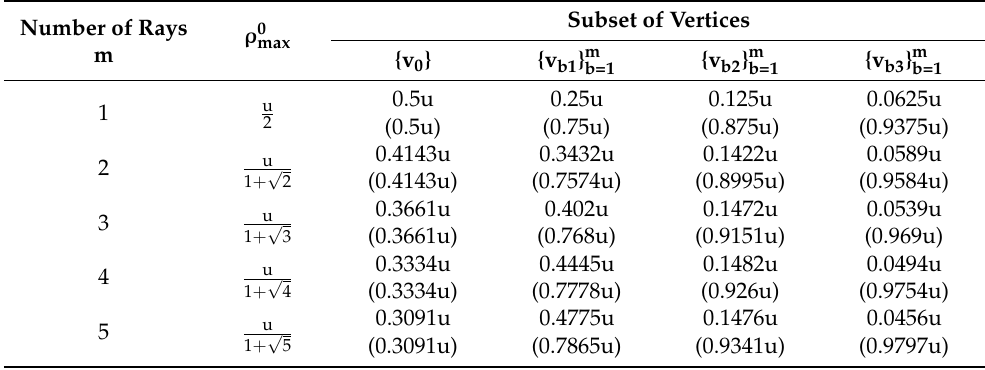
Table 2. Upper estimates for the risk increment in a structure with m rays on subsets of vertices that are away from the perimeter by 1–3 edges, as well as the corresponding upper estimates for the integral risk values; rounding is to the fourth digit with excess. Number of